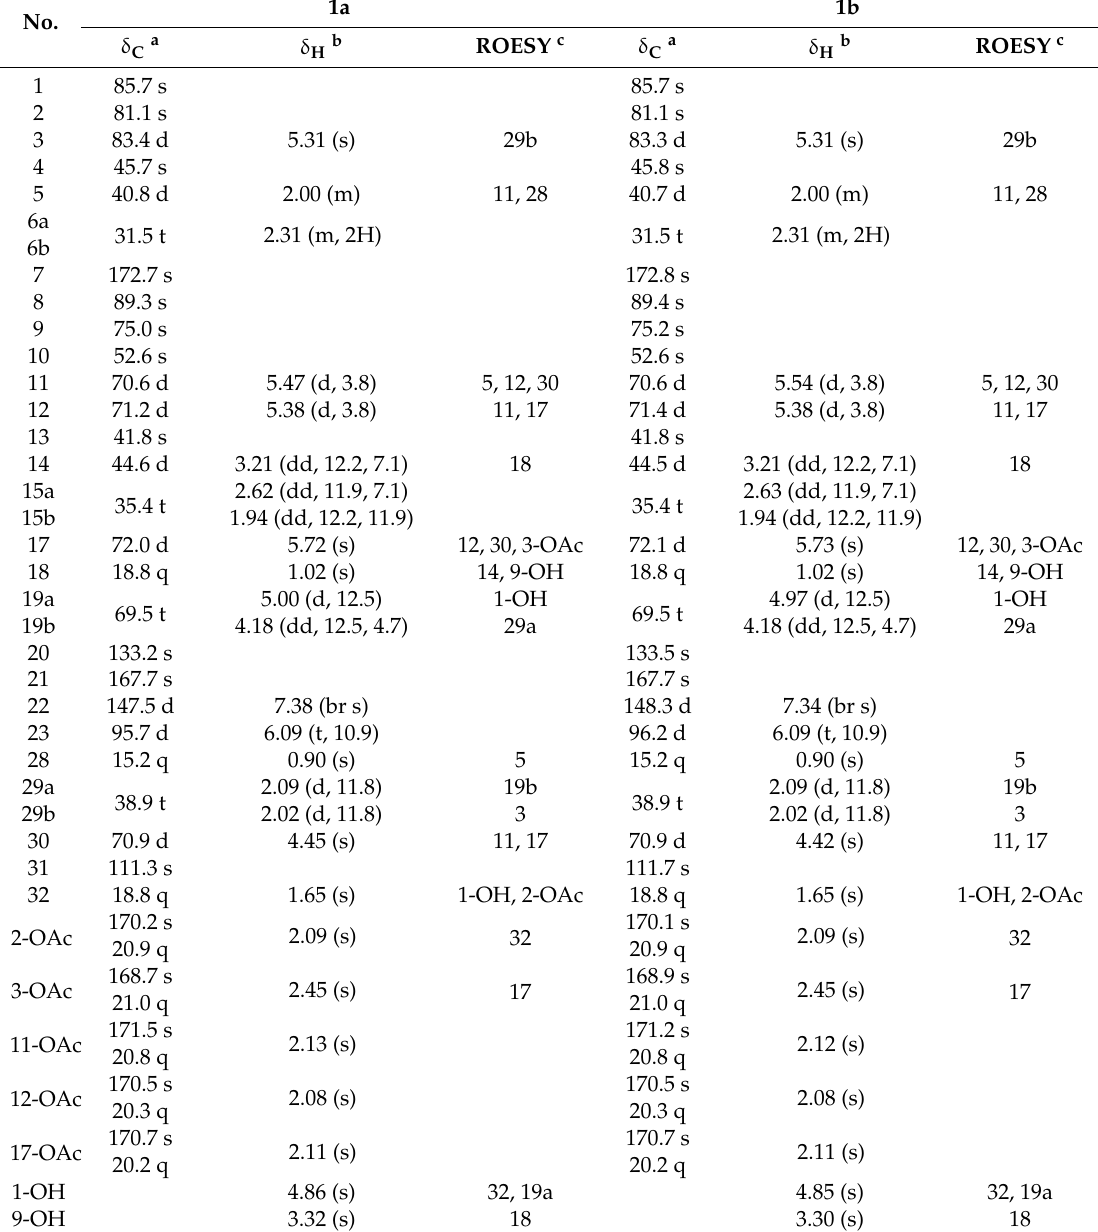
Table 1. NMR spectroscopic data of compound 1 (isomers 1a and 1b ) in CDCl 3 ( δ in ppm, J in